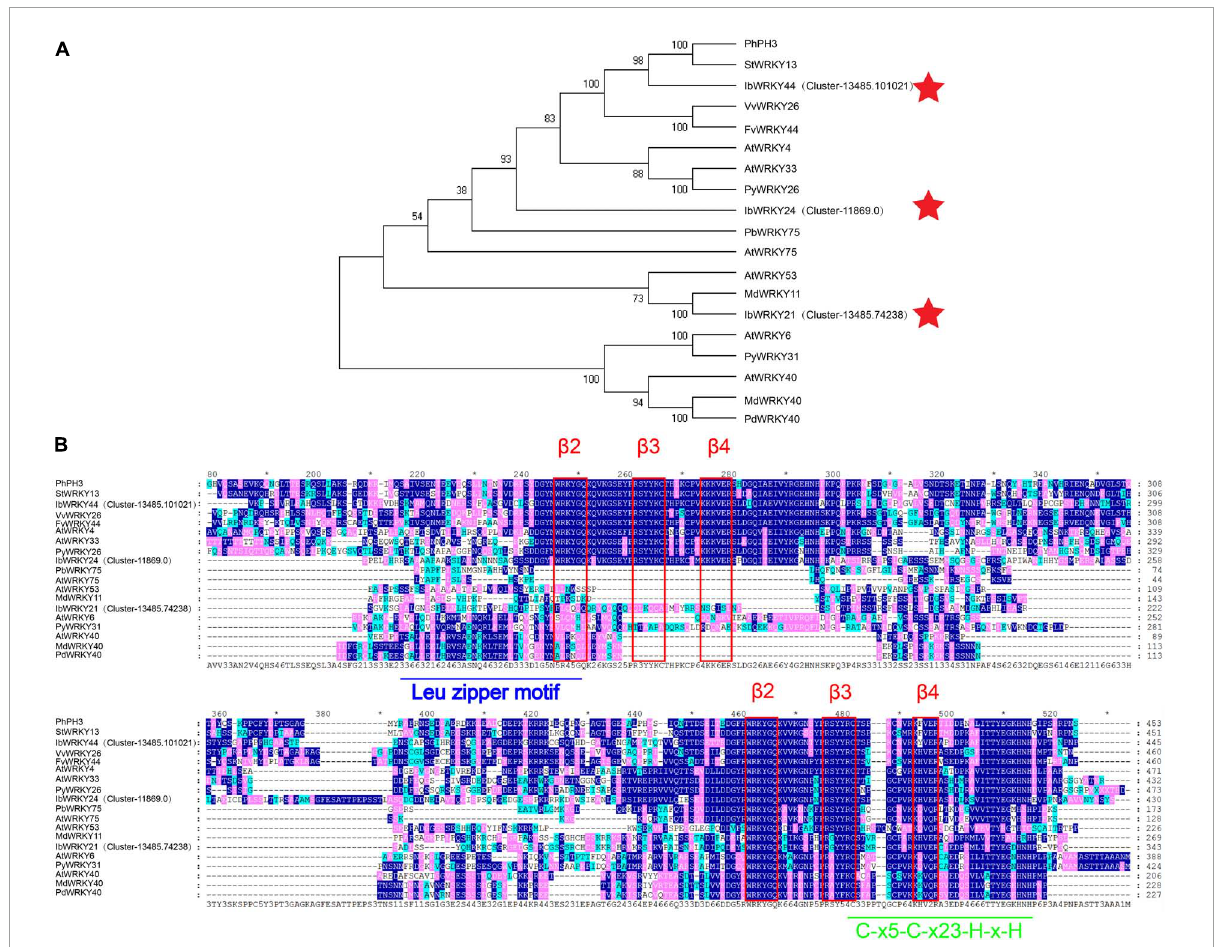
FIGURE4 Phylogenetic analysis and protein sequence alignment for the putative WRKYs with function-verified homologous genes of other plant species. (A) Phylogenetic relationship of putative WRKYs in sweet potato and function-verified anthocyanin-related WRKYs in other species. Pentagram represents WRKYs screened from RNA-seq. (B) Protein sequence alignment for the putative MYBs with function-verified homologous genes of other plant species. Blue and green lines represent the Leu zipper motif and C-x 5 -C-x 23 -H-x-H motif, respectively. The red rectangle represents the β 2- β 3- β 4